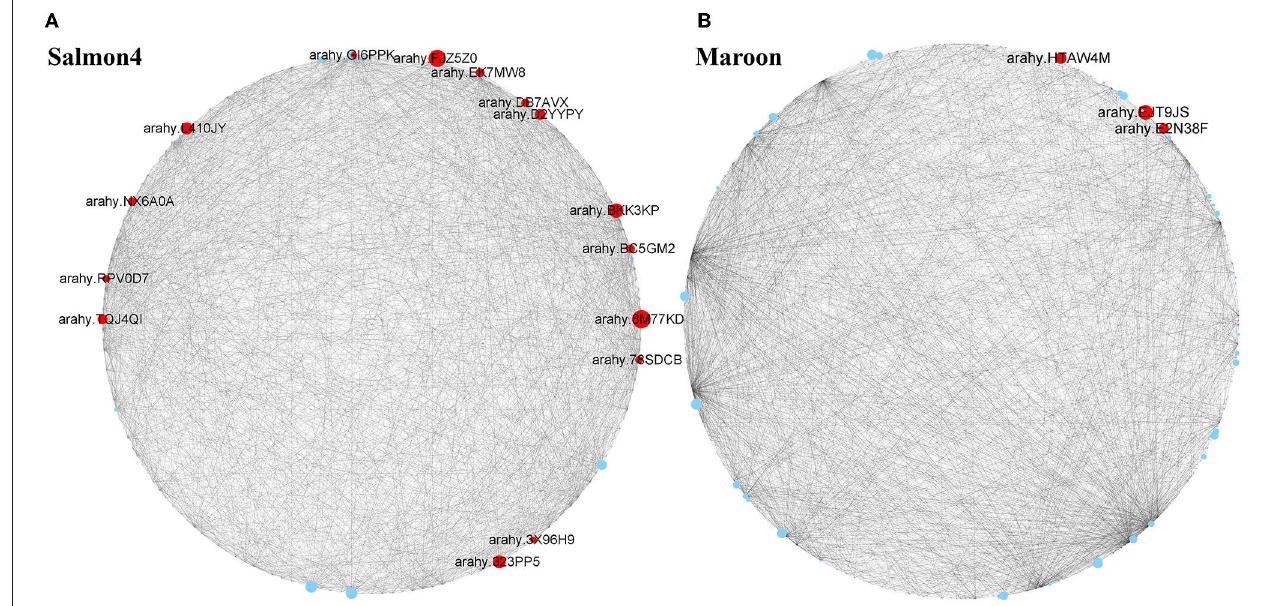
FIGURE 7 | Hub genes identified in maroon and salmon4. Co-expressed network analysis of salmon4 module (A) and maroon module (B) . The size of the node circle is positively correlated with the number of genes it interacts with. Hub genes are shown as red nodes.